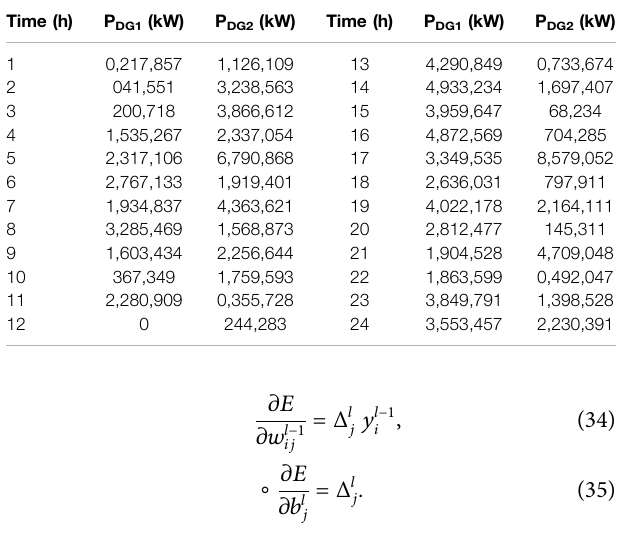
TABLE 4 | Diesel generators generate optimal power P DG e (cid:1) 250. Time (h) P DG1 (kW)